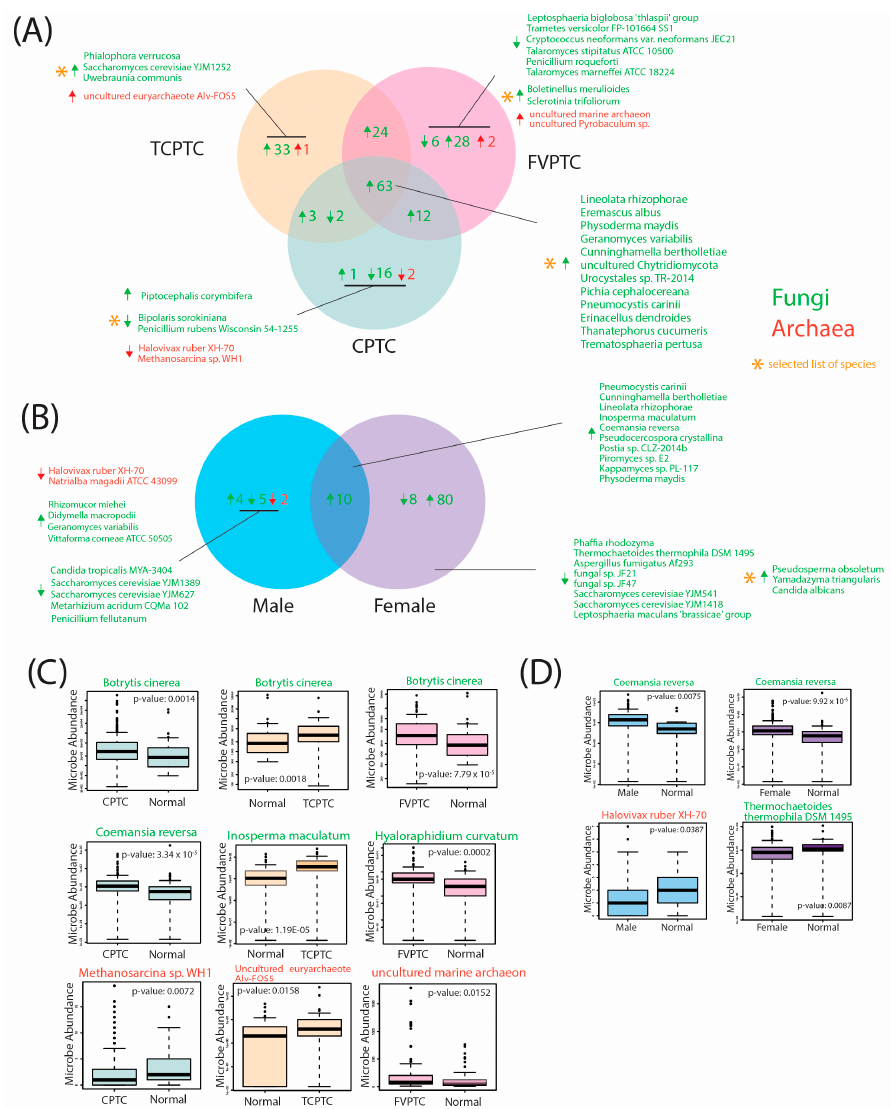
Figure 3. Characterization of the mycobiome and archaeome across PTC subtype and gender com- parisons suggest unique dysregulation between these cohorts. Differential abundance analysis was performed in order to compare abundance of fungal and archaeal species in CPTC, TCPTC, FVPTC, male, and female tumor tissue samples to adjacent normal and gender-controlled adjacent normal samples. Significantly differentially abundant microbes were defined by a p -value of <0.05 and a log-fold change (FC) > 1. Fungal and archaeal species are displayed in green and red fonts, respec- tively. Arrows were used to visualize the direction of abundance: upward-facing arrows indicate overabundance of microbial species in the specified cohort(s), downward-facing arrows indicate underabundance of microbial species in the specified cohort(s). Asterisks indicate that only certain microbes in the comparison group were visualized in the figure. A complete list of significantly dysregulated microbes were included in Supplementary File S2. ( A ) Venn diagram displaying se- lected commonly significantly dysregulated microbes and the direction of abundance between CPTC, TCPTC, and FVPTC tumor tissue samples compared to adjacent normal tissue. ( B ) Venn diagram displaying selected commonly significantly dysregulated microbes and the direction of abundance between male and female PTC tumor tissue samples compared to adjacent normal tissue. ( C ) Selected boxplots of significantly dysregulated microbes from PTC subtype analysis. p -values obtained from the Kruskal–Wallis test are indicated on each microbe plot. ( D ) Selected boxplots of significantly dysregulated microbes from gender comparison analysis. p -values obtained from the Kruskal–Wallis test are indicated on each microbe